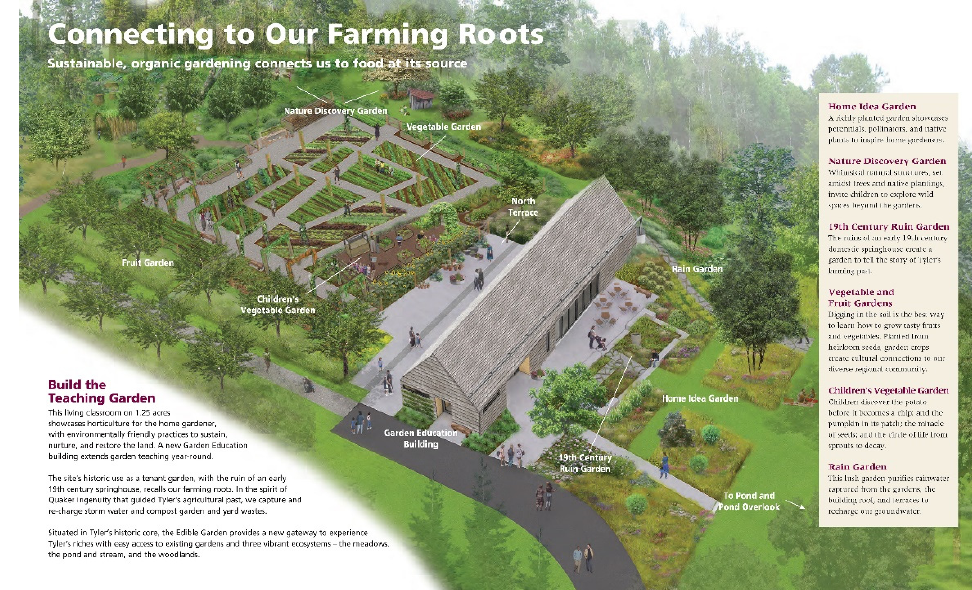
Figure 5. Tyler’s Edible Garden Project [46].